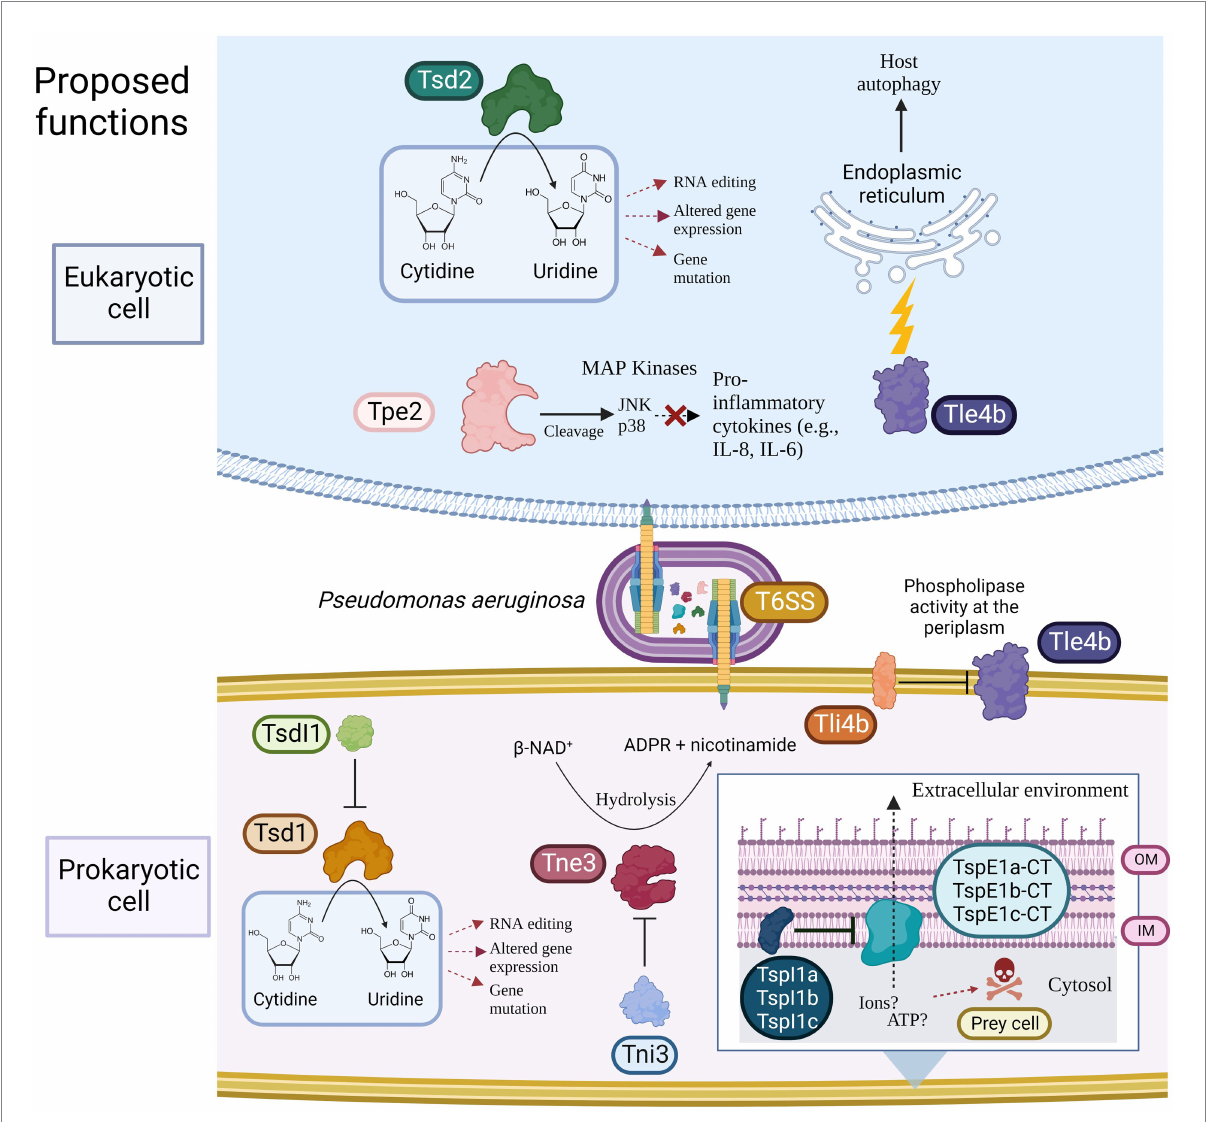
FIGURE 1 Model showing the predicted toxic functions of the eight putative T6SS effectors identified in this study towards either eukaryotic and/or prokaryotic cells. Putative immunity proteins are shown if present. T6SS = Type VI secretion system, Tsd = Type Six Cytidine Deaminase Effector, TsdI = Type Six Cytidine Deaminase Immunity, Tne/i = Type Six NADase Effector/Immunity, Tpe/i = Type Six Metallopeptidase Effector/Immunity, Tle/i = Type Six Lipase Effector/Immunity TspE/I = Type Six Pyocin Effector/Immunity, OM = Outer membrane, and IM = Inner membrane. Created using